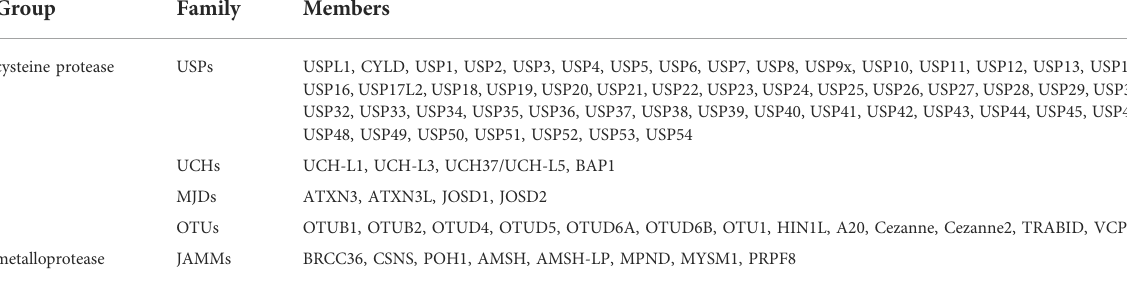
TABLE 1 Members of protein deubiquitination enzymes.